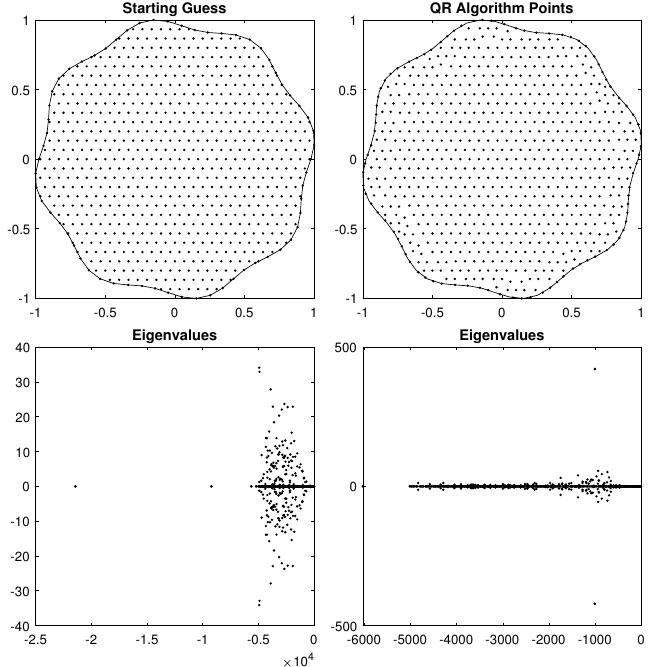
Figure 15. Hexagonal points and resulting MCpQR algorithm points with Dirichlet Laplacian eigenvalues for the bumped-disk region.